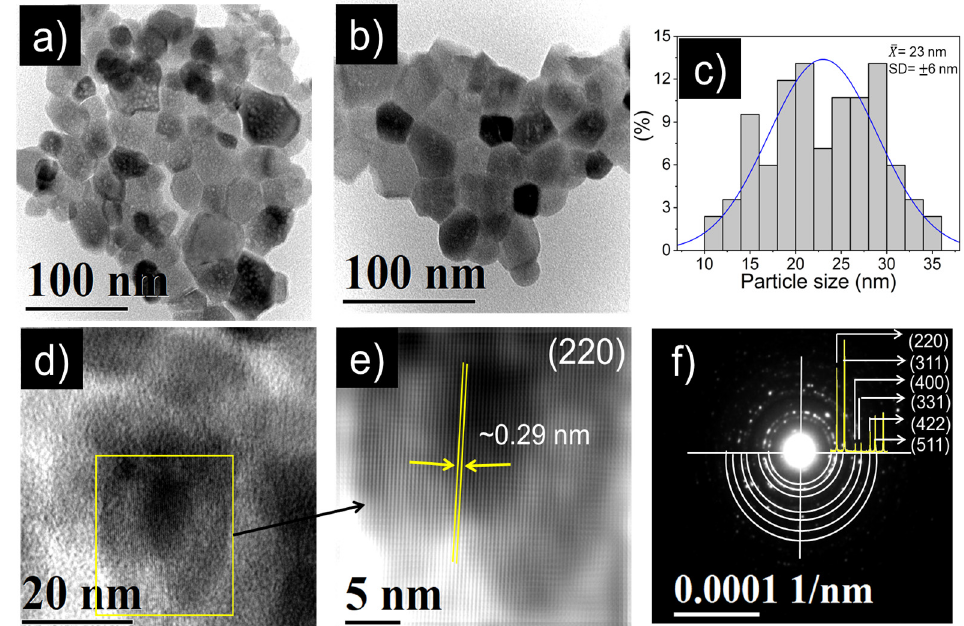
Figure 8. TEM analysis of the ZnAl 2 O 4 synthesized at 700 °C: ( a , b ) nanoparticles with mesopores, ( c ) particle size distribution, ( d , e ) HRTEM images, ( f ) electron diffraction pattern and its correspondence with XRD.